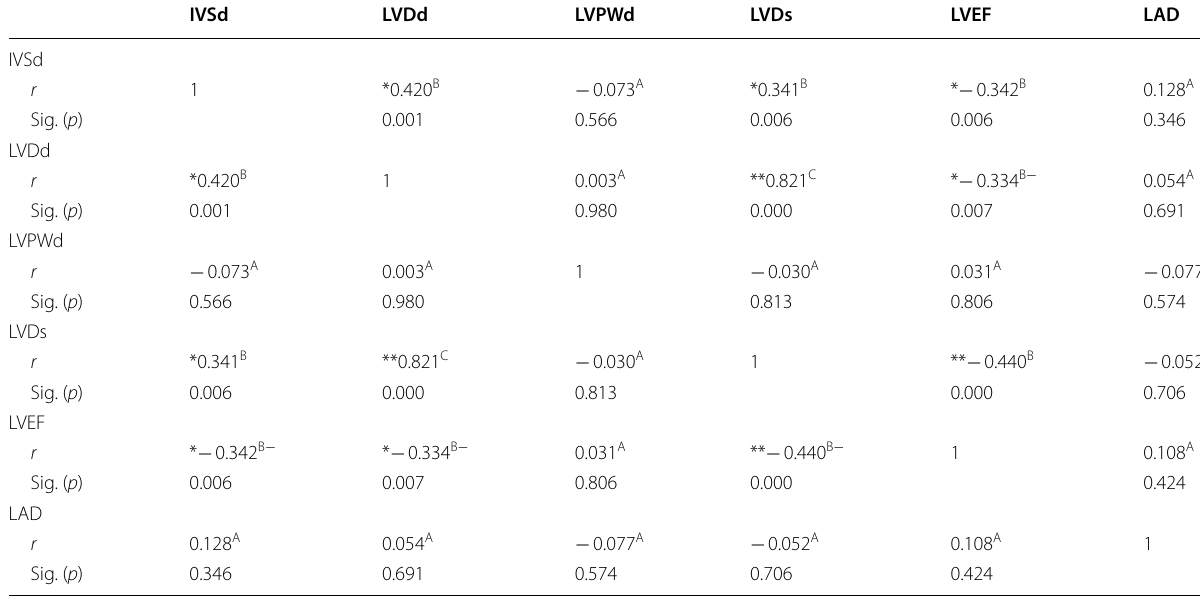
Table 5 Pearson correlations eco